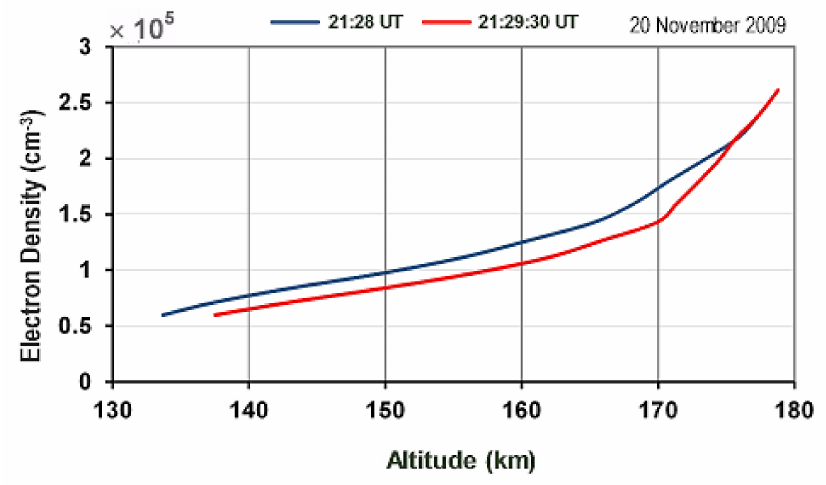
Figure 6. Electron density distributions at the two recording times.